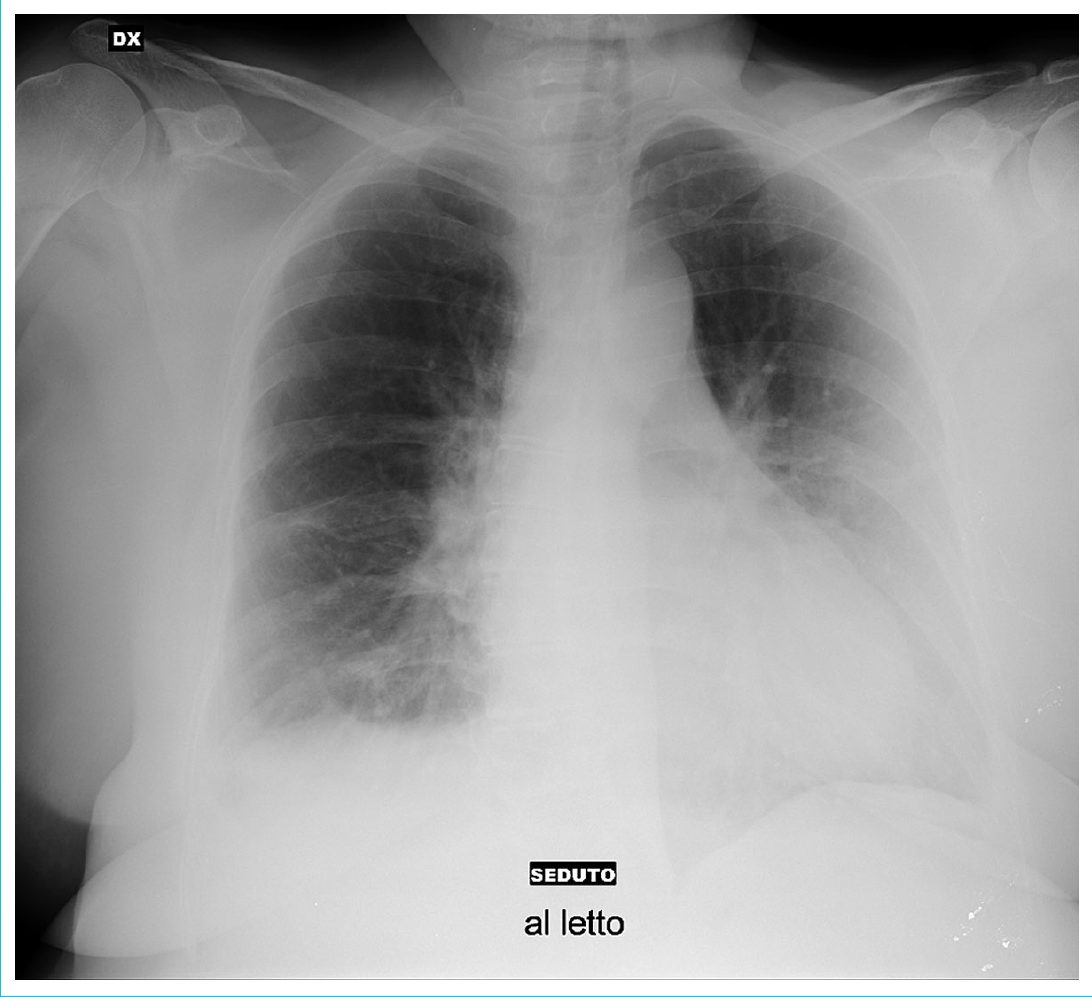
Figure 2: chest x-ray of patient 1 on day 6 after admission, 16 March 2020. Courtesy Ospedale di Sassuolo. It shows a marked reduction of the opacities noted in figure.1 (see detailed radiological description in the